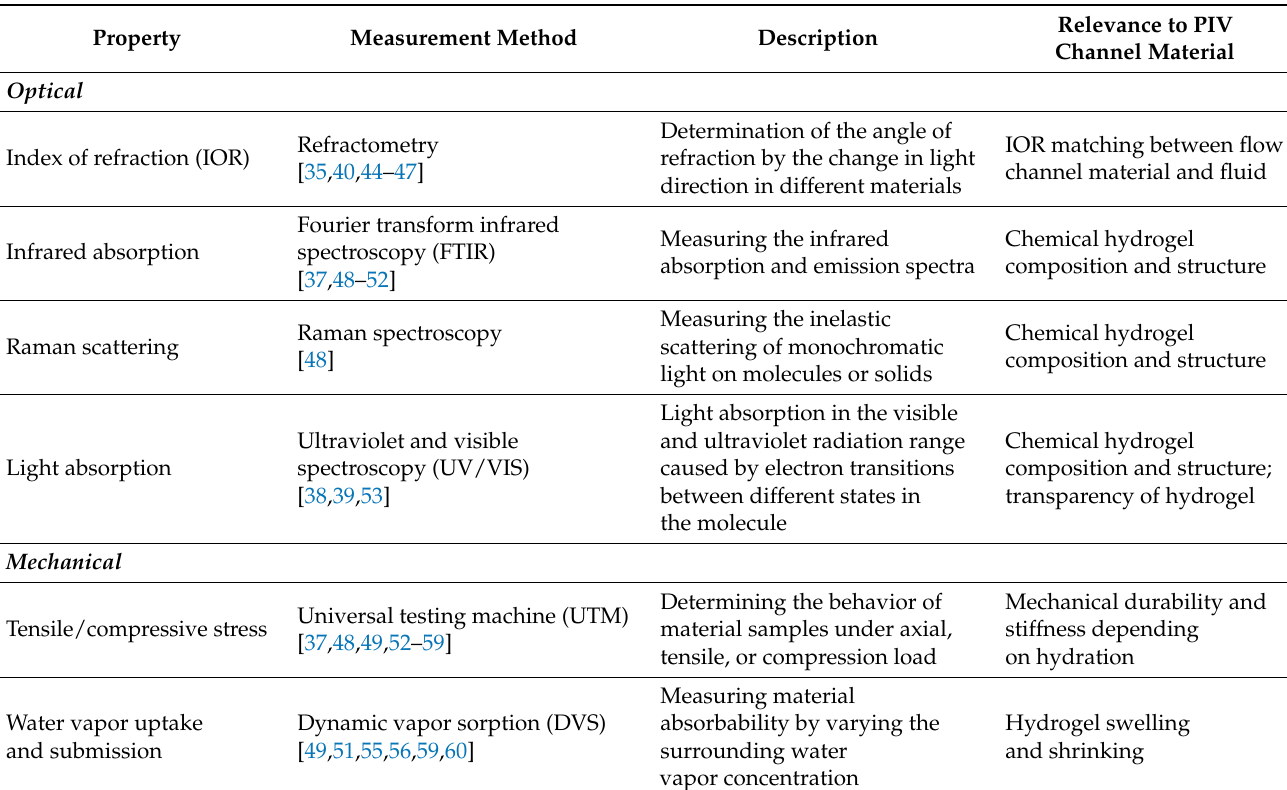
Table 1. Overview and description of hydrogels’ optical and mechanical measurement methods and their relevance for this review.